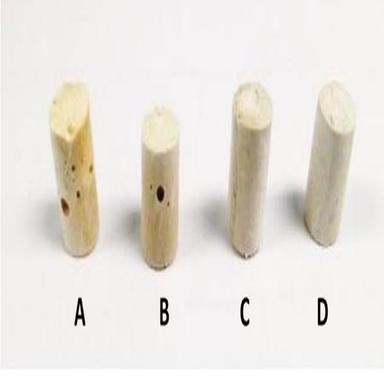
Sample images (PR24).